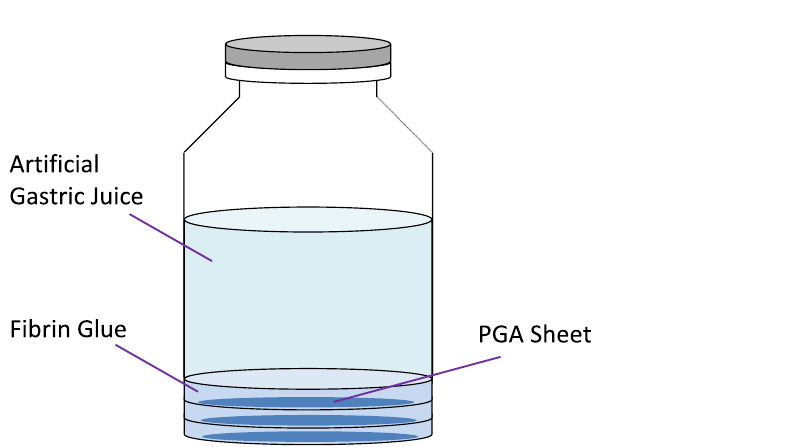
Figure 2. Samples used in this experiment. Three layers of 1-mm fibrin gel and polyglycolic acid sheet are made in the vial (thickness of 3 mm in total). A sample for measurement is prepared by adding 10 mL of the artificial gastric